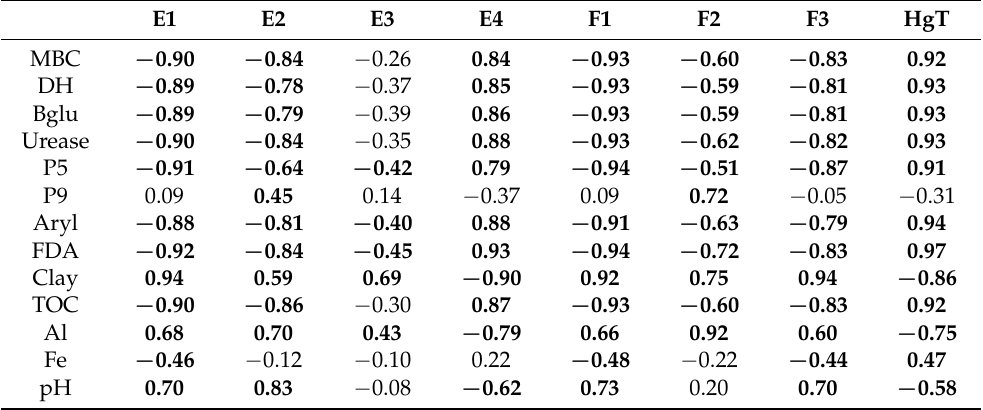
Table 4. Pearson correlation coefficients ( n = 30) between enzymes activities, soil parameters and mercury mobility; bold values are significant at the p < 0.05.